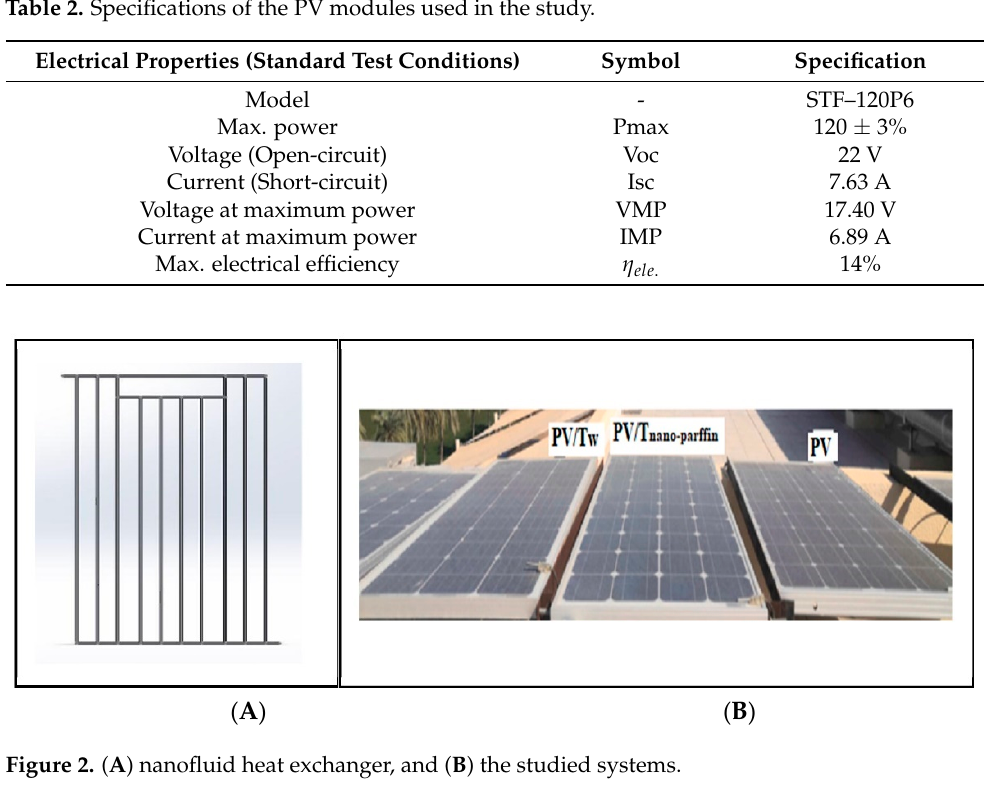
Figure 2. ( A ) nanofluid heat exchanger, and ( B ) the studied systems. Table 2. Specifications of the PV modules used in the study.